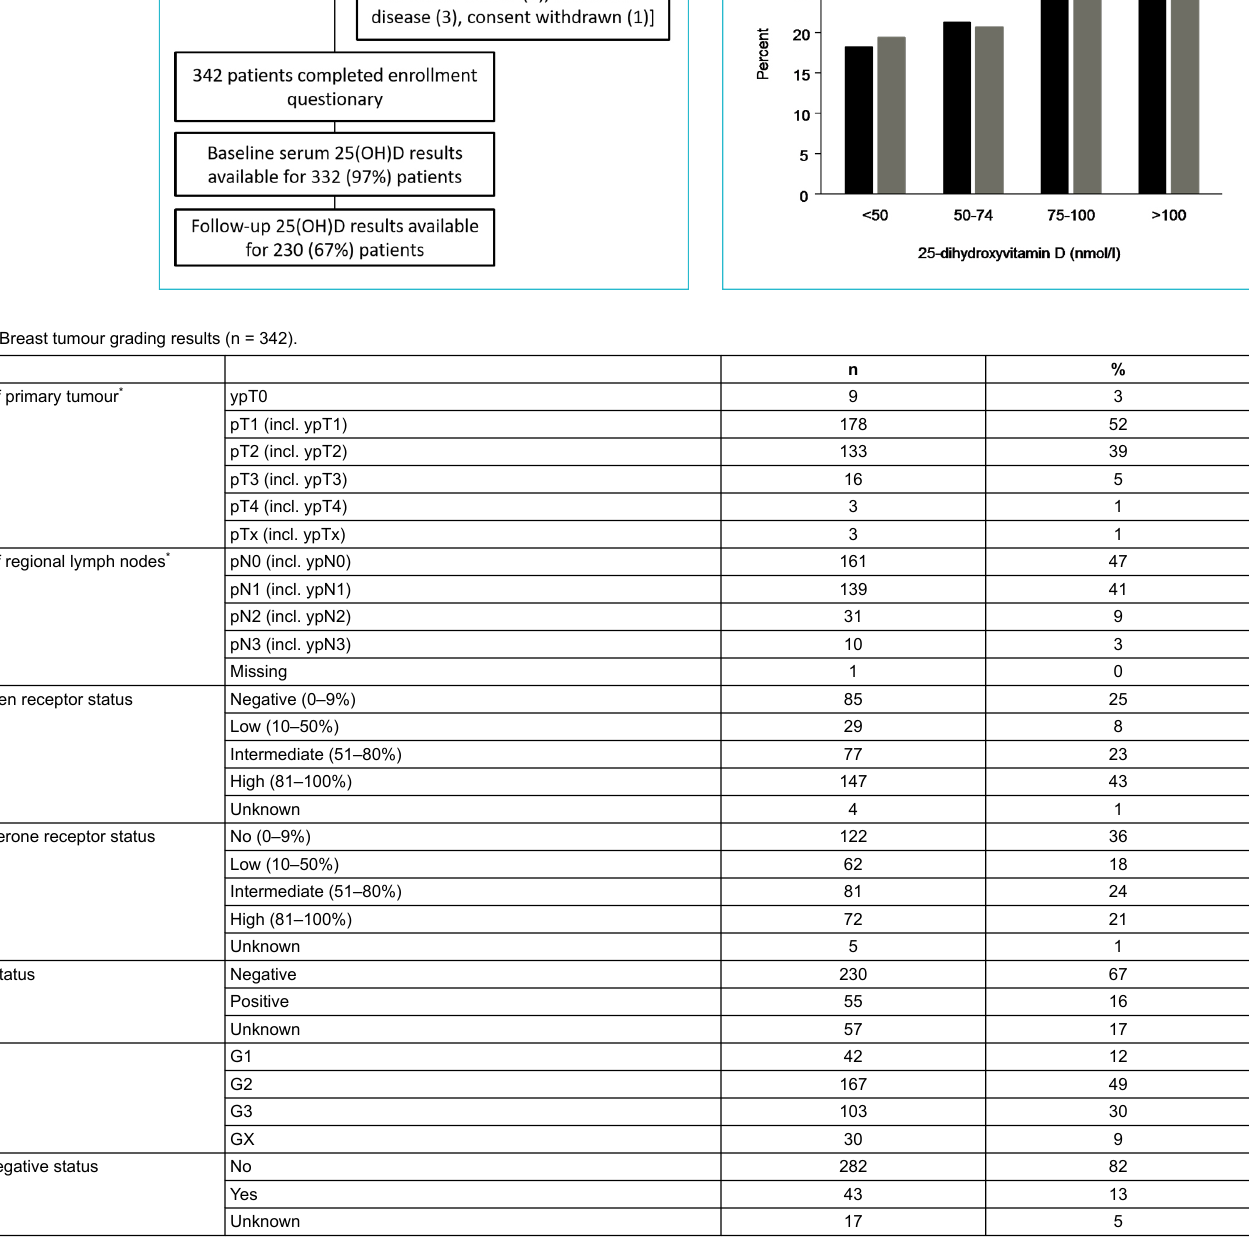
Figure 2: Distribution of the patients according to internationally accepted categories of serum 25-dihydroxyvitamin D (25(OH)D) levels: deficiency (<50 nmol/l), insufficiency (50–74 nmol/l), optimal level (75–100 nmol/l) and physiological level above optimum (>100 nmol/l). Note that the proportion of patients in each category did not change appreciably in the follow-up visit at median 210 days (range 87–857 days) after the first visit.